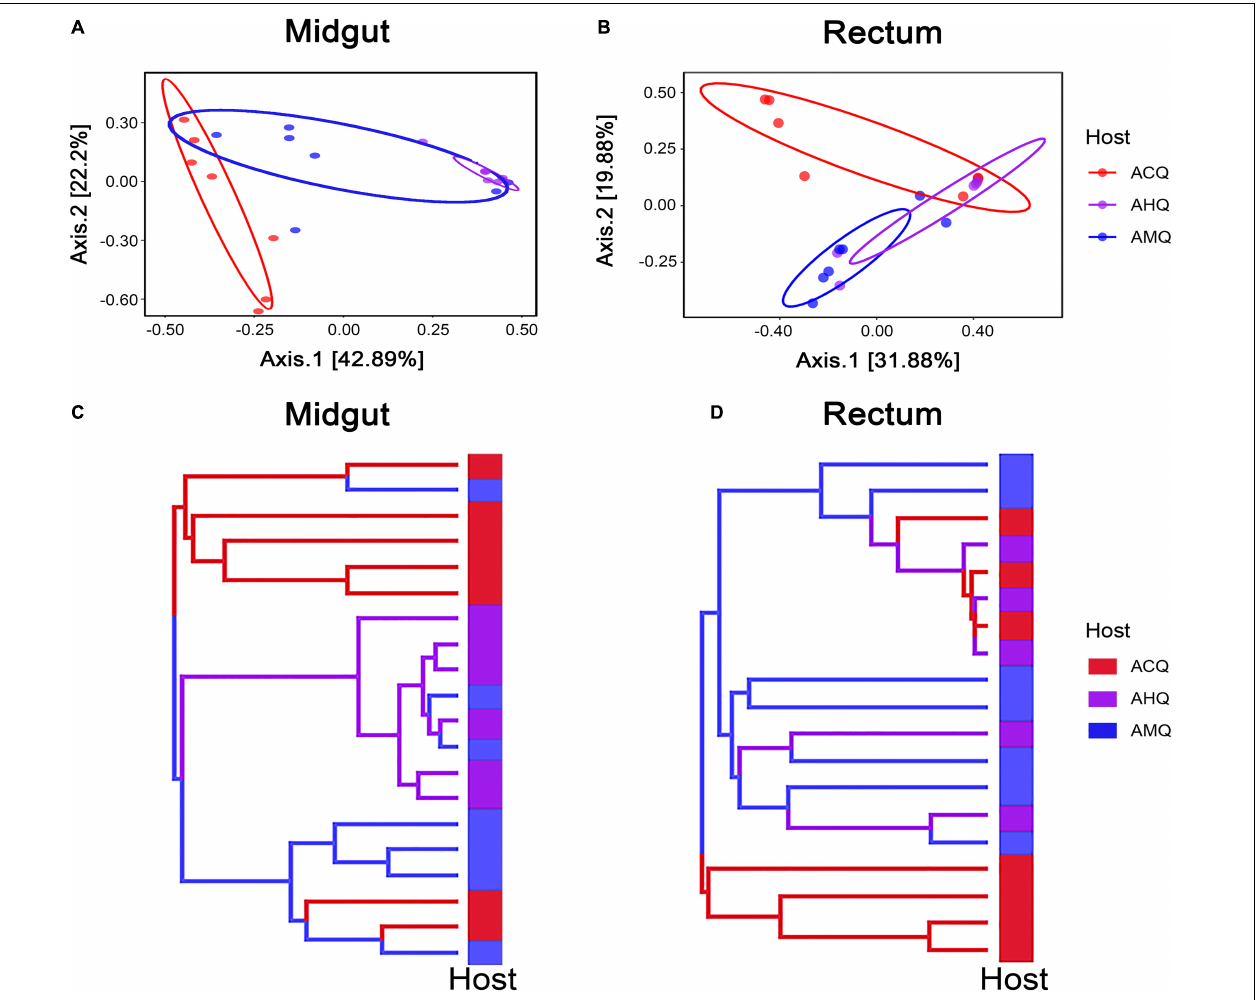
FIGURE 3 | High microbiota similarities between AHQs and AMQs. (A,B) β -Diversities of bacterial communities are clustered using principal coordinate analysis (PCoA) based on Bray–Curtis dissimilarity (results of unweighted UniFrac distance are shown in Supplementary Figures 2A,B ). Each dot on the plot represents the entire microbiota of a gut tissue sample, and the dots were colored correspondingly. (C,D) The dendrograms rebuilt using the UPGMA method based on Bray–Curtis dissimilarity. Each topological branch is also colored the same as